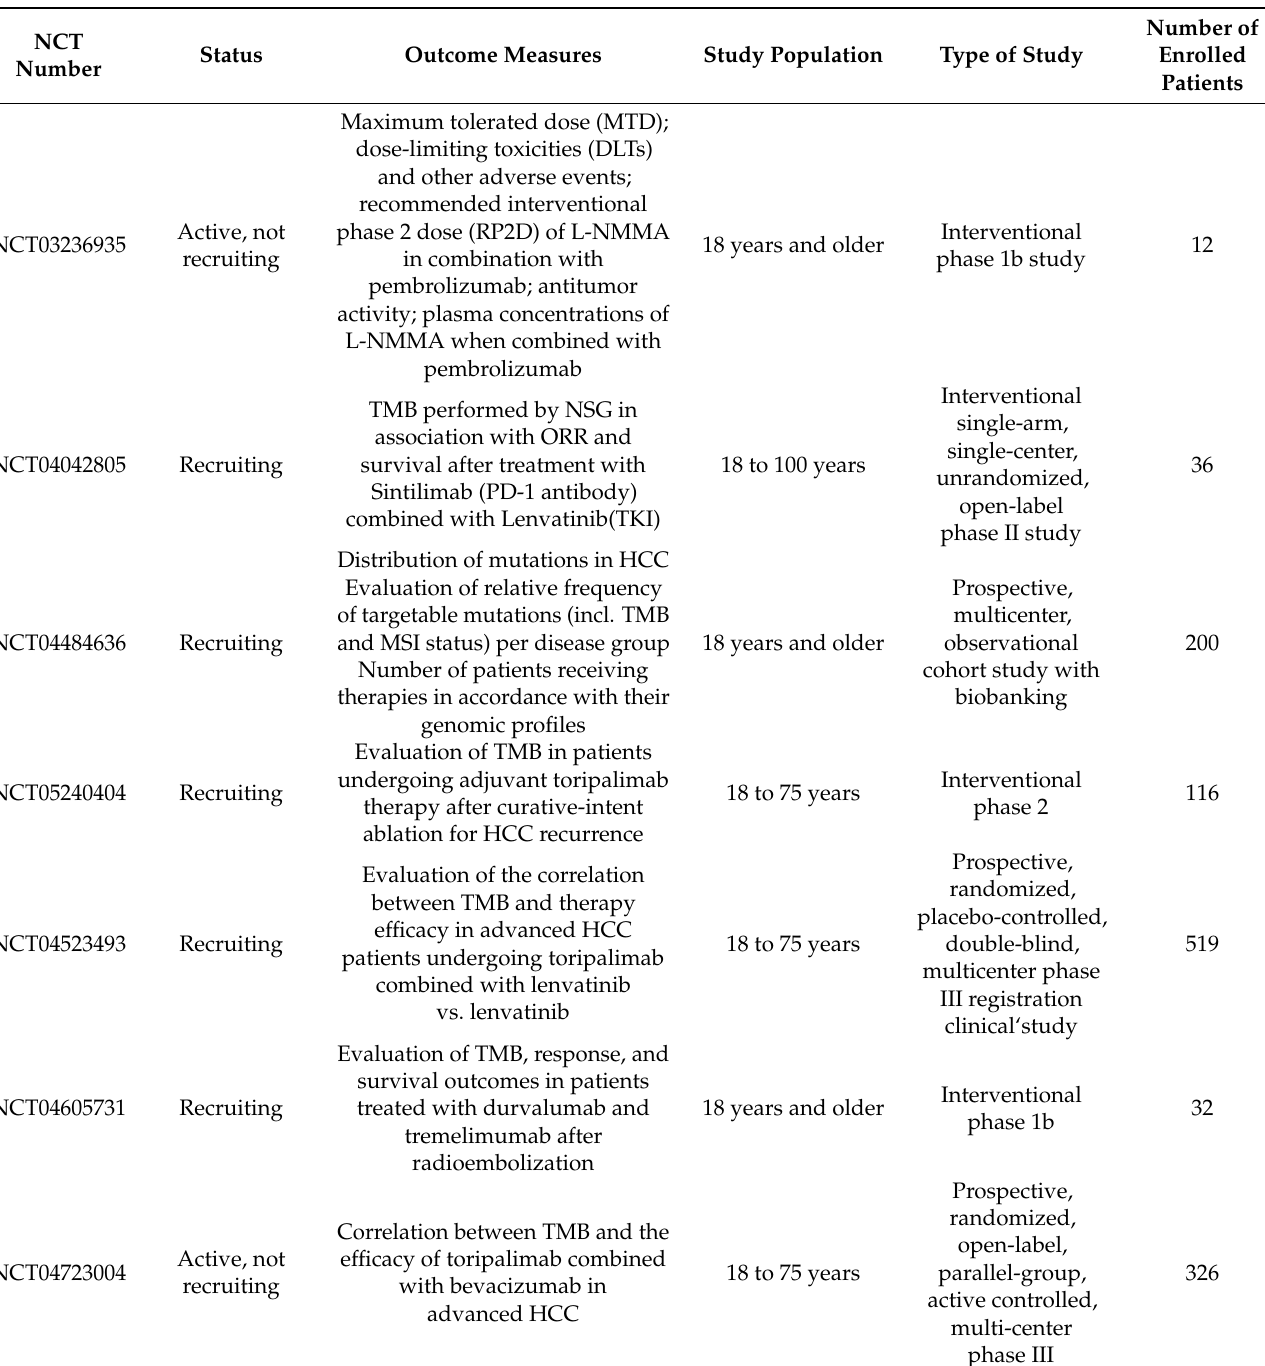
Table 2. Ongoing clinical trial investigating the use of TMB as a biomarker for prediction of HCC progression and therapy outcome (downloaded from https://www.clinicaltrials.gov/ accessed on 2 February